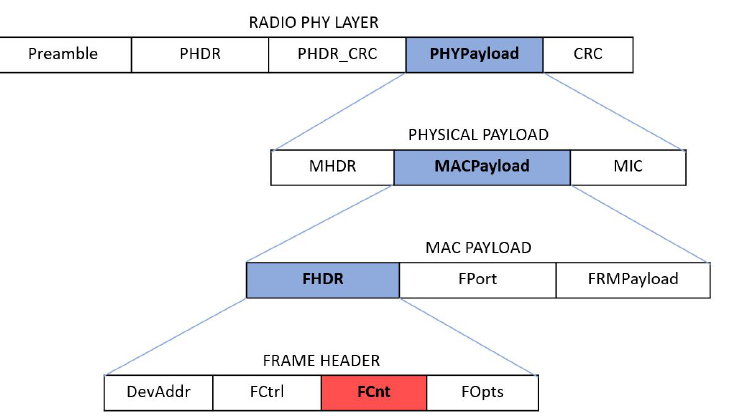
Figure 5. Structure of LoRa packet represented in a hierarchical schema. The CRC field in the radio physical layer is present only in uplink